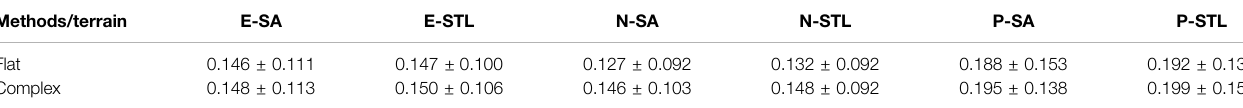
TABLE 3 | The means and standard deviations of SOS CV for different terrains from 2001 to 2017.